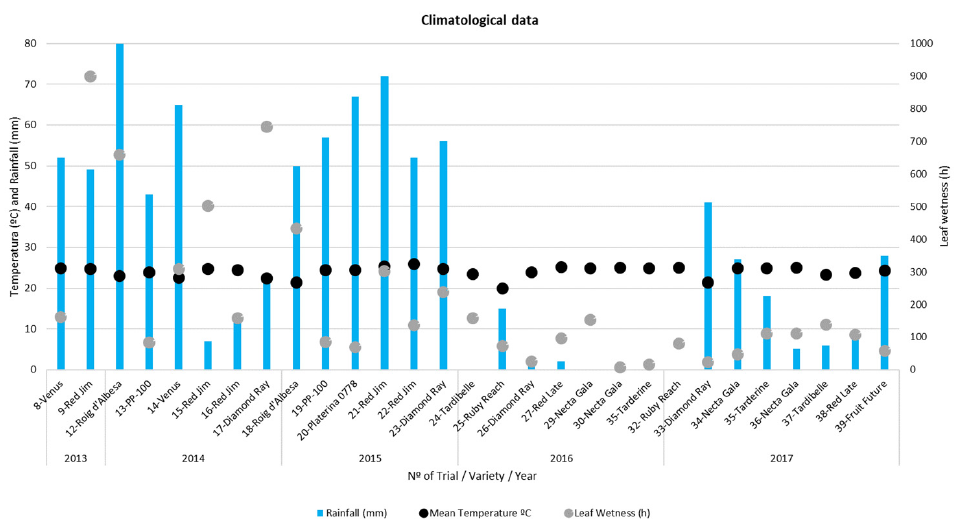
Figure 8. Temperature (°C), rainfall (mm), and Leaf wetness (h) for each treatment evaluated along the 6 seasons in the period within the warning system were validated. Note: data from 2012 and trials 6, 7, 10, and 11 are not plotted in Figure 6.